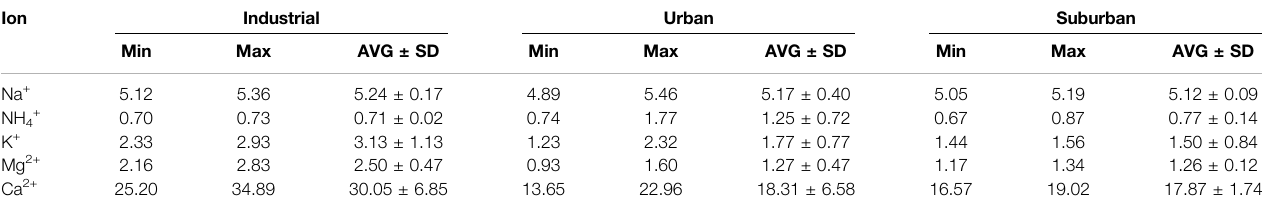
TABLE 3 | Mass concentration of water-soluble ions in PM 10 in three locations. Ion Industrial Urban